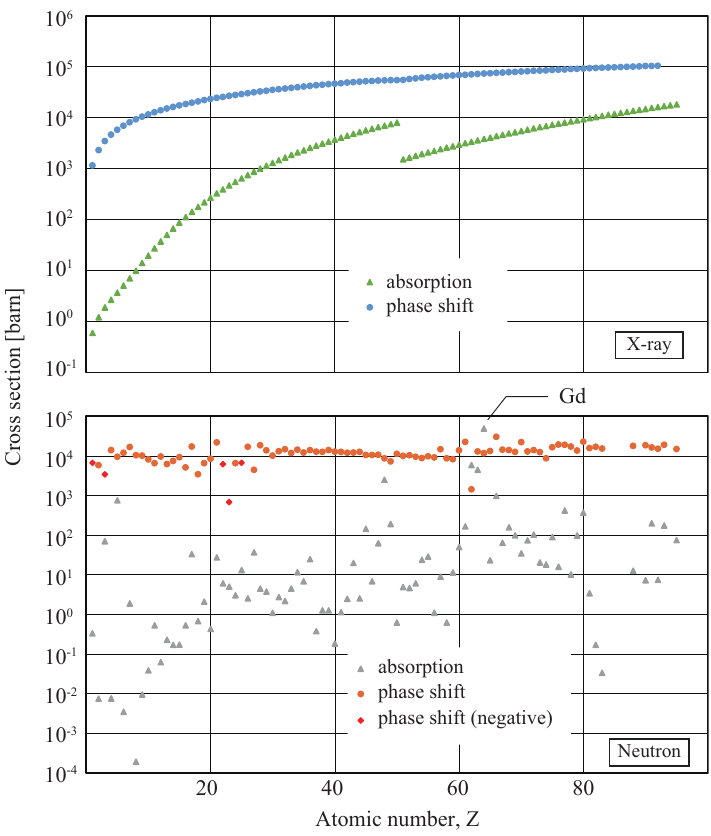
Figure 1. Interaction cross sections per atom of absorption and phase shift for X-rays (30 keV) and neutrons (25